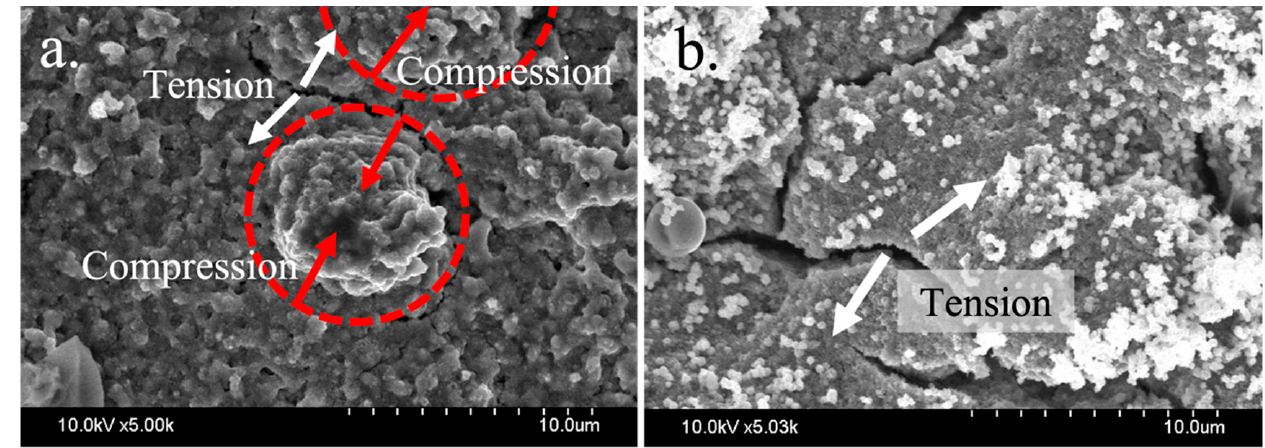
Figure 20. ( a ) 2-W laser output causes reginal compression strain; ( b ) excess reginal strains result in significant cracks, which were created by 2.5-W laser output.